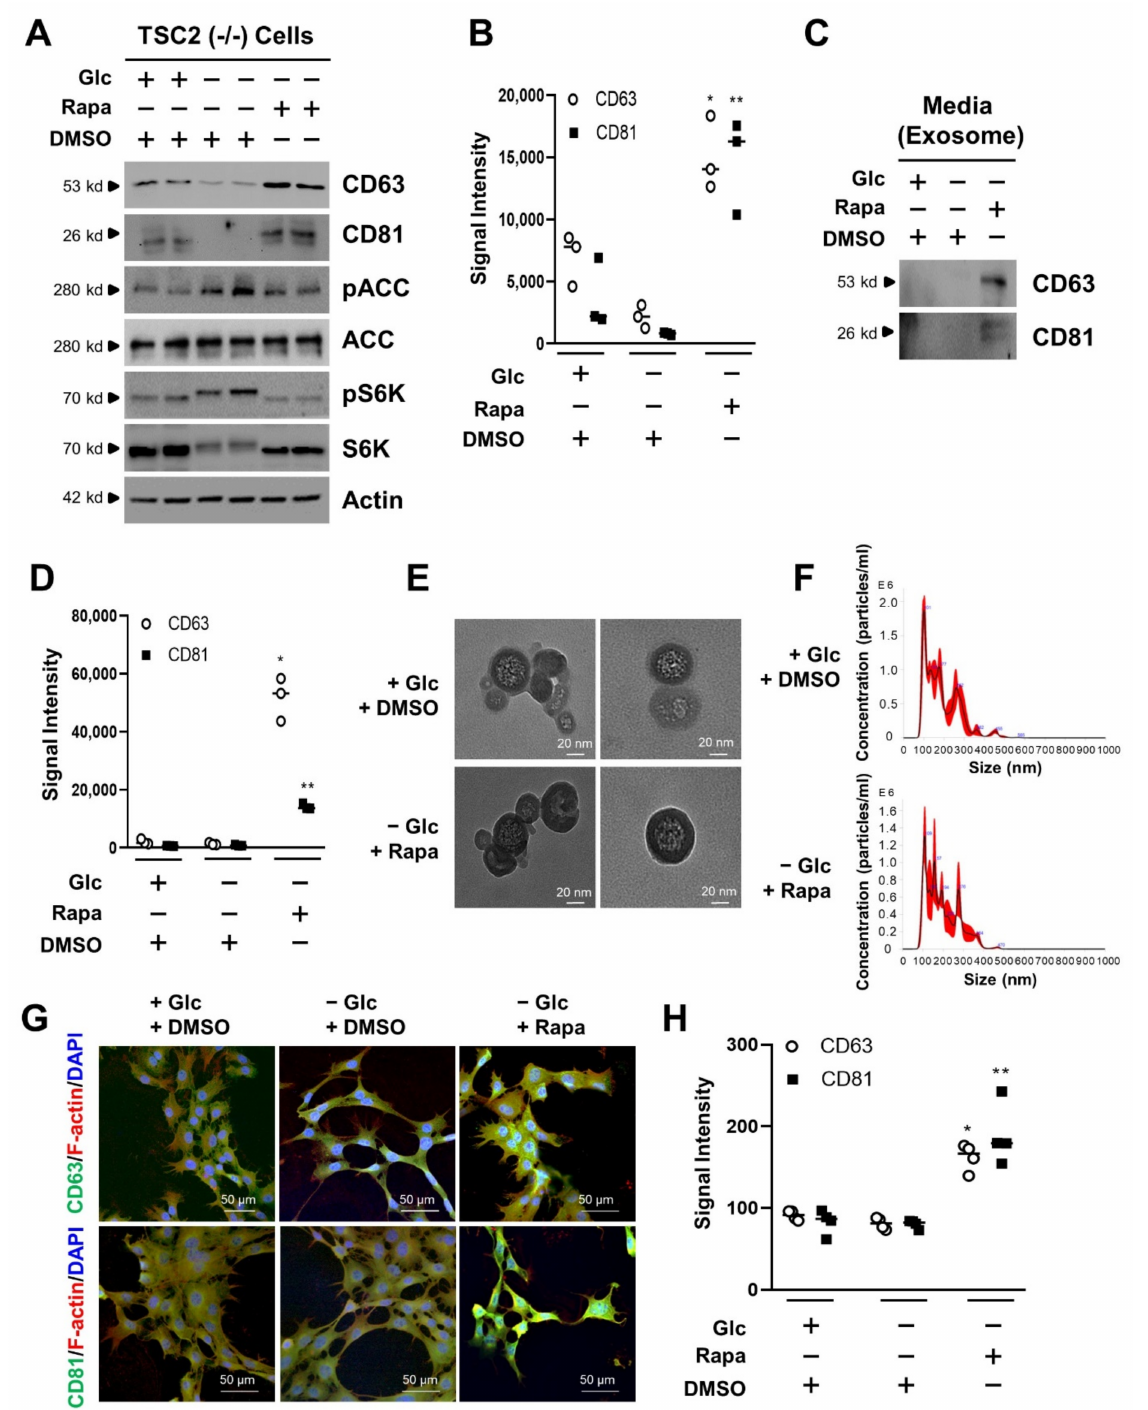
Figure 1. Effects of exosome release by mTORC1 inhibition in TSC2-null cells. ( A ) TSC2 ( − / − ) MEF cells were cultured with completed media. During serum starvation, cells were cultured in the absence or presence of glucose for 48 h. Rapamycin (100 nM) was treated in the absence of glucose for 24 h. The cells were harvested, lysed, and analyzed by immunoblotting with the indicated antibodies. Actin was used as a loading control. ( B ) The dot plot graph was quantified from three-independent immunoblotting data. The CD63, and CD81 are exosome marker proteins. These proteins were quantified to improve accuracy and show the measurable value. The quantification was performed with UN-SCAN-IT gel program. The detailed method is described in the materials and